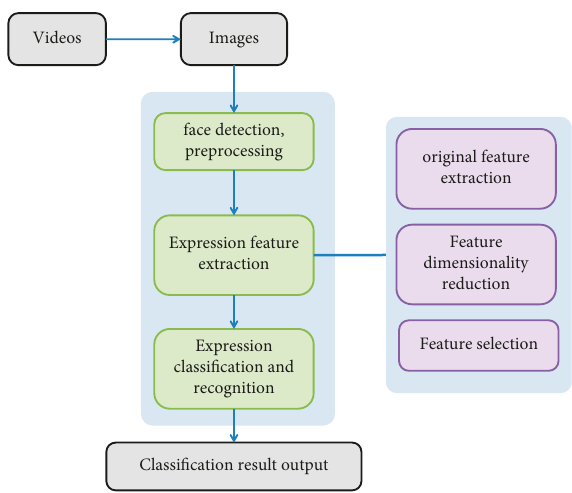
Figure 2: Emotion recognition process based on